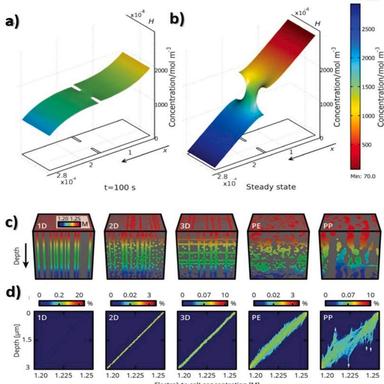
Development of the ionic concentration distribution in the electrolyte layer with inserted separator. a) 100 s after applying a constant current, b) the steady state. The applied current is 0.72 A. c) Concentration profiles and d) concentration density maps from steady-state Fickian diffusion simulations across the throughplane direction of artificially generated and recorded datasets of 3 µm edge length with a concentration difference of ≈50 mm between top (1.25 m) and bottom (1.20 m). Repro